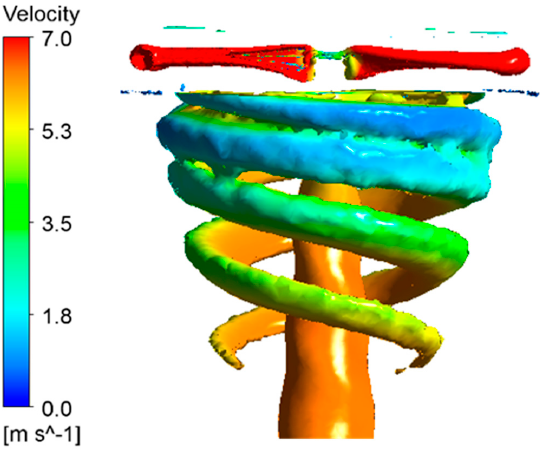
Figure 13. Free wake of the rotor.